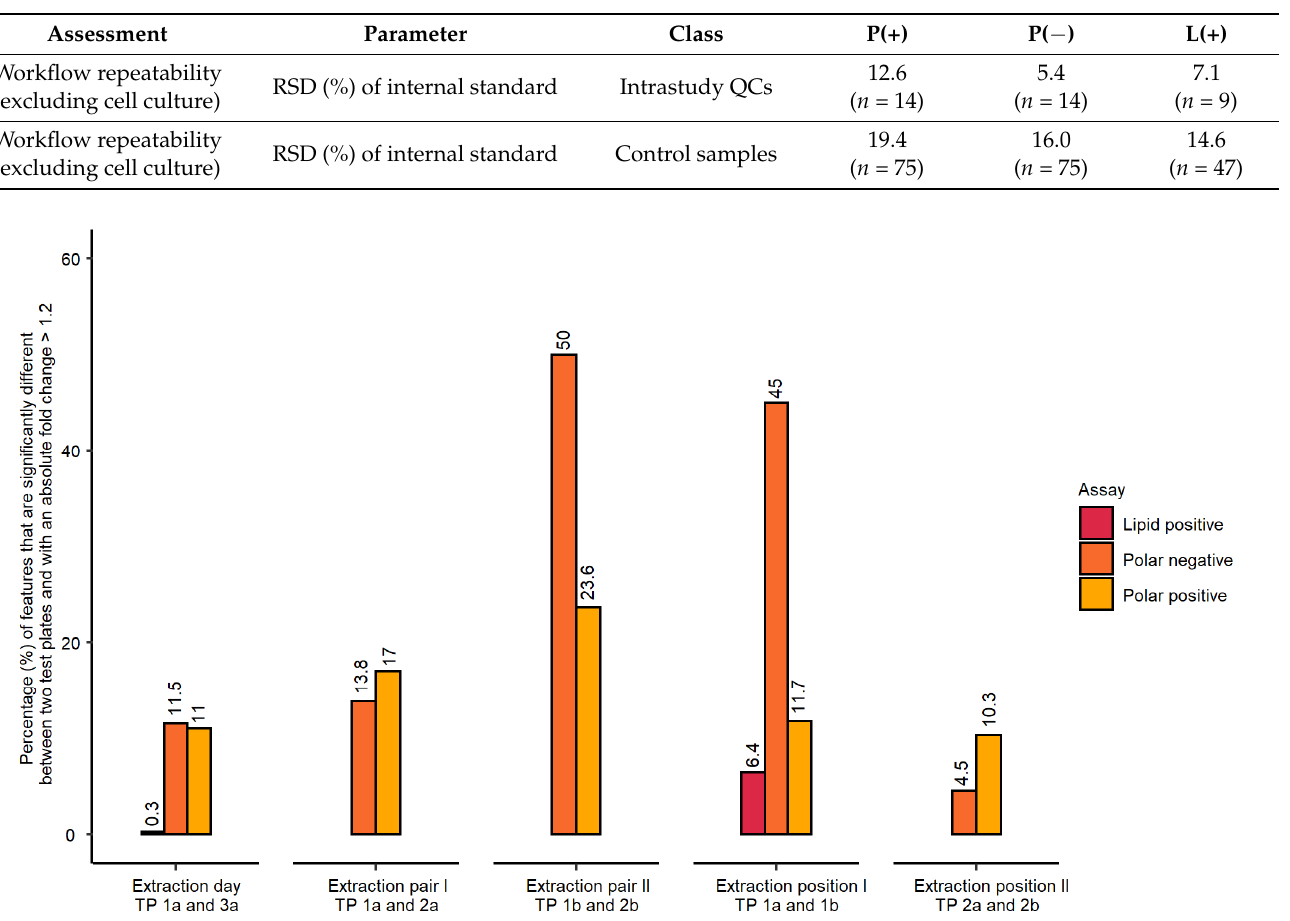
Table 2. Assessment of the automated in vitro metabolomics workflow’s repeatability based on a spec- tral feature putatively assigned to the internal standards: L-tryptophan-d 5 for polar metabolomics assays and dodecylphosphorylcholine-d 38 for the lipid assay ([M+H] + or [M − H] − for positive and negative ion modes, respectively). P(+), P( − ), L(+) correspond to polar positive, polar negative and lipid positive nESI-DIMS assays. For the measurement of repeatability, the number of replicates is given in brackets below the RSD value.